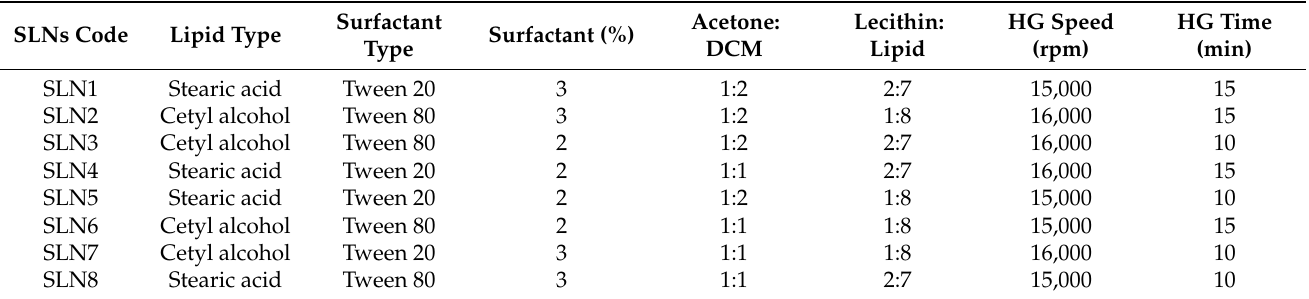
Table 1. Predicted independent variables (N = 7) by DoE in the preparation of